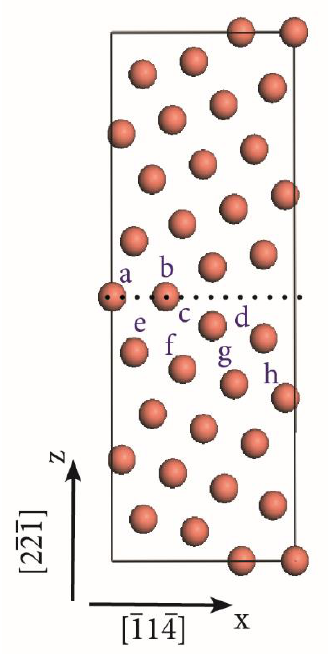
Figure 1. Geometry optimized Σ9 grain boundaries (GB) employed to study the segregation of P and S. Atomic sites (a to h) where the segregation of P and S as substitutional impurities was studied.